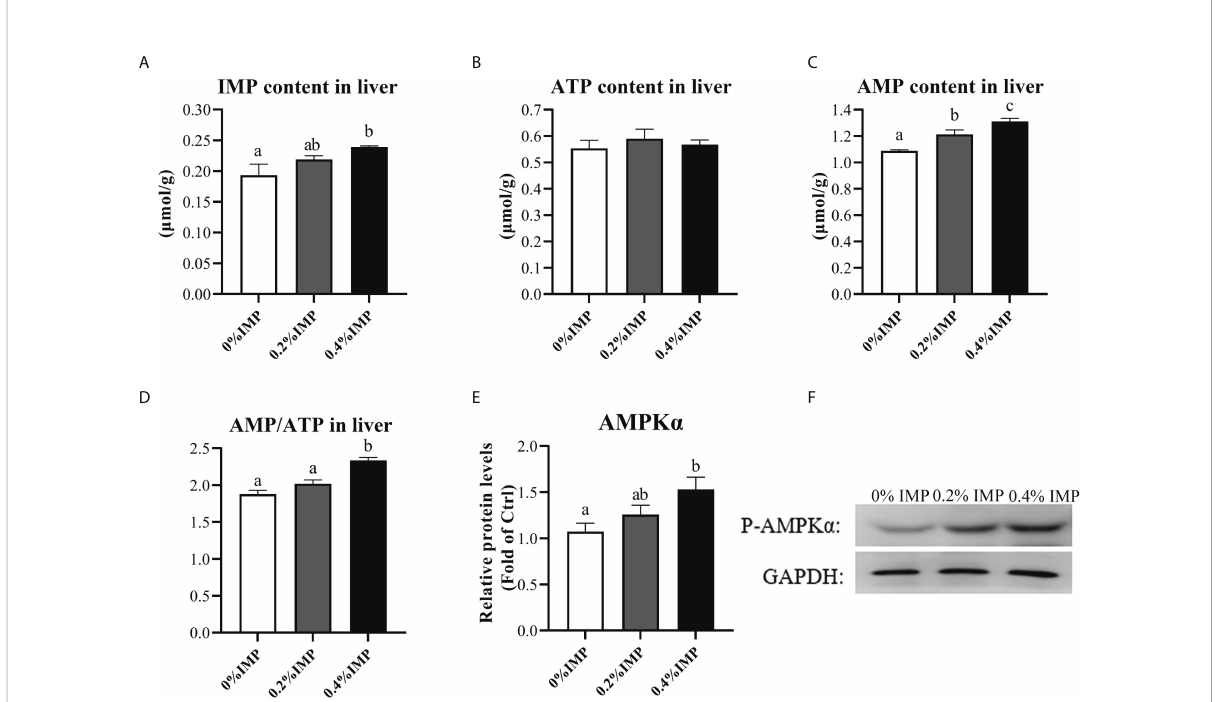
FIGURE 3 Dietary IMP supplementation activates the AMPK pathway by altering the ratio of AMP/ATP. (A) IMP content in the liver of groups. (B) Adenosine 5 ′ -triphosphate (ATP) content in the liver of groups. (C) Adenosine 5 ′ -monophosphate (AMP) content in the liver of groups. (D) Ration of AMP and ATP in the liver of groups. (E) The image quantization results of AMPK protein phosphorylation. (F) AMPK protein phosphorylation in the liver was measured by western blot. Columns represent the mean ± SEM (n=6). For each index, bars without sharing a common letter indicate signi fi cant differences ( P